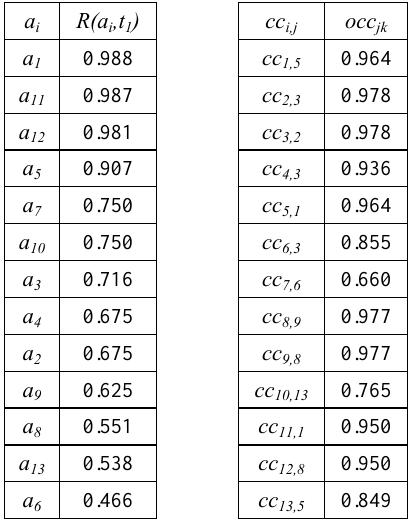
Fig. 4. The performance of the proposed model Final, we apply the proposed model to six